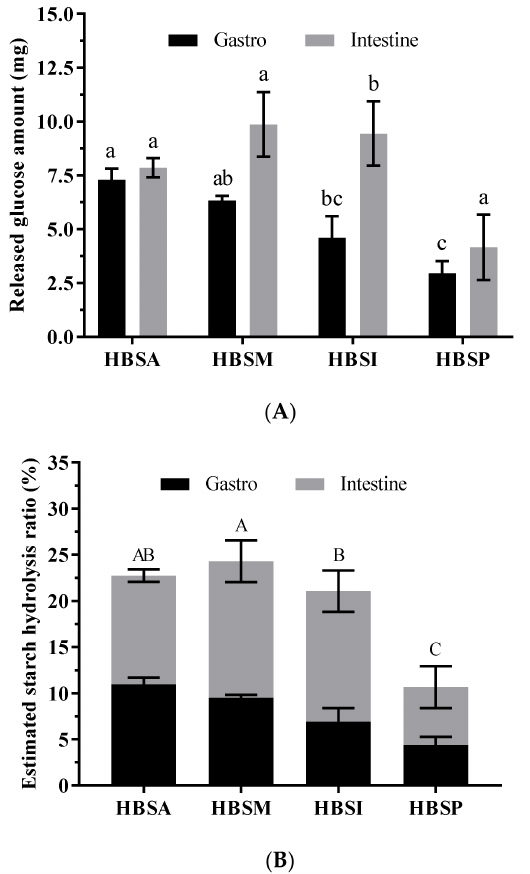
Figure 3. The released glucose contents ( A ) and estimated hydrolysis ratios ( B ) of HBSA, HBSM, HBSI, and HBSP during simulated gastrointestinal digestion. Values with different letters were significantly different ( p < 0.05). Lowercase letters indicated differences among the released glucose amounts within the same digests. Capital letters indicated differences among the estimated starch hydrolysis